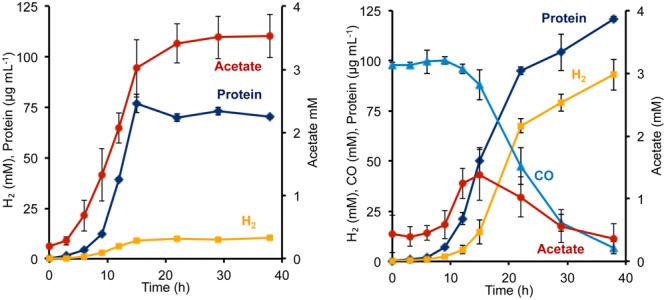
Growth characteristics of P. furiosus strain Codh in the absence (left) and presence (right) of CO with limiting maltose (0.5 g L-1) and yeast extract (1 g L-1). Compounds are represented as follows: blue triangles, CO; dark blue diamonds, cell protein; orange squares, H2; red circles, acetate. Error bars represent SD, n = 3.